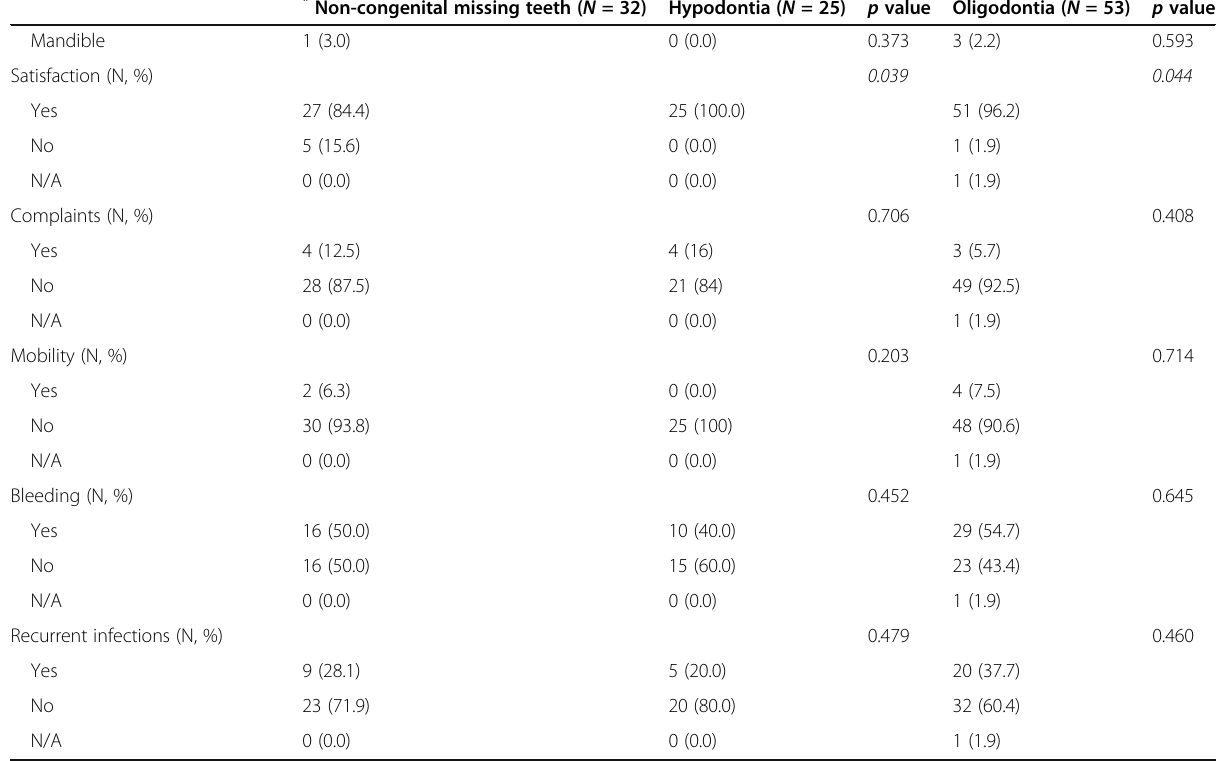
Table 2 Baseline characteristics of the study population